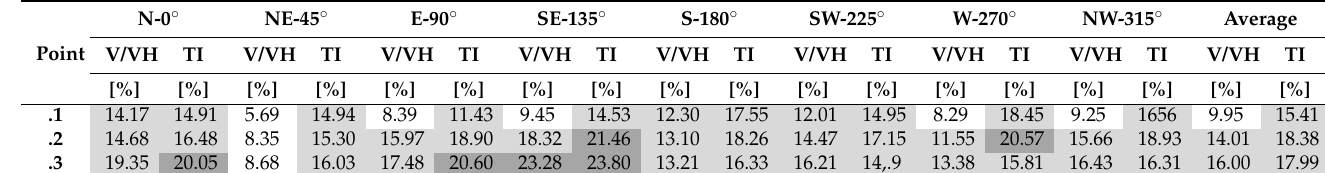
Table 10. Mean Absolute deviation results from OpenFOAM per height and sector. V/VH is the ratio between velocity (V) and velocity at the top of the boundary layer achieved by the model (VH); TI is the turbulence intensity. Values shadowed by dark grey represent deviations with values ≥ 20% or ≤− 20% while values shadowed by light grey color represent deviation values ≥ 10% or ≤− 10% and no shadowed values have deviation values > − 10% or values < 10%. Points denoted by .1 or .2 or .3 mean height above ground at 9 m, 12 m, and 17 m, respectively.